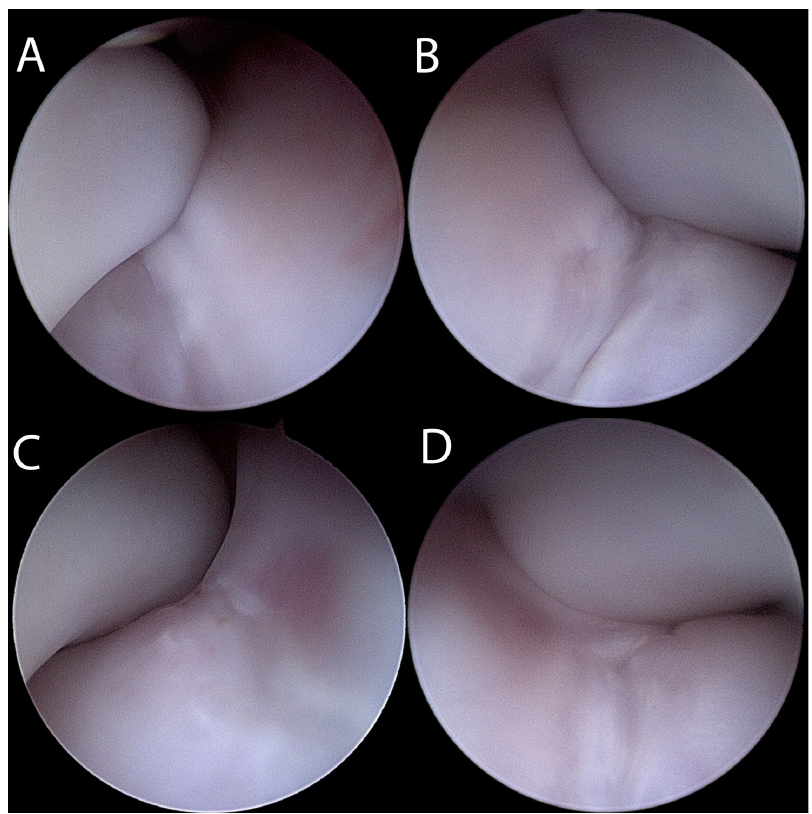
Figure 1. Arthroscopic images of the left elbow ( A , C ) and of the right elbow ( B , D ) using a caudal portal. Note the positioning of the anconeal process matching the cartilaginous lesion when the elbow is held at a weight-bearing angle (120°–140°) ( A , B ). When the joint is extended, the anconeal process displaces more proximally into the supratrochlear foramen revealing the partial thickness cartilage lesion on the caudal aspect of the humeral condyle ( C , D ).